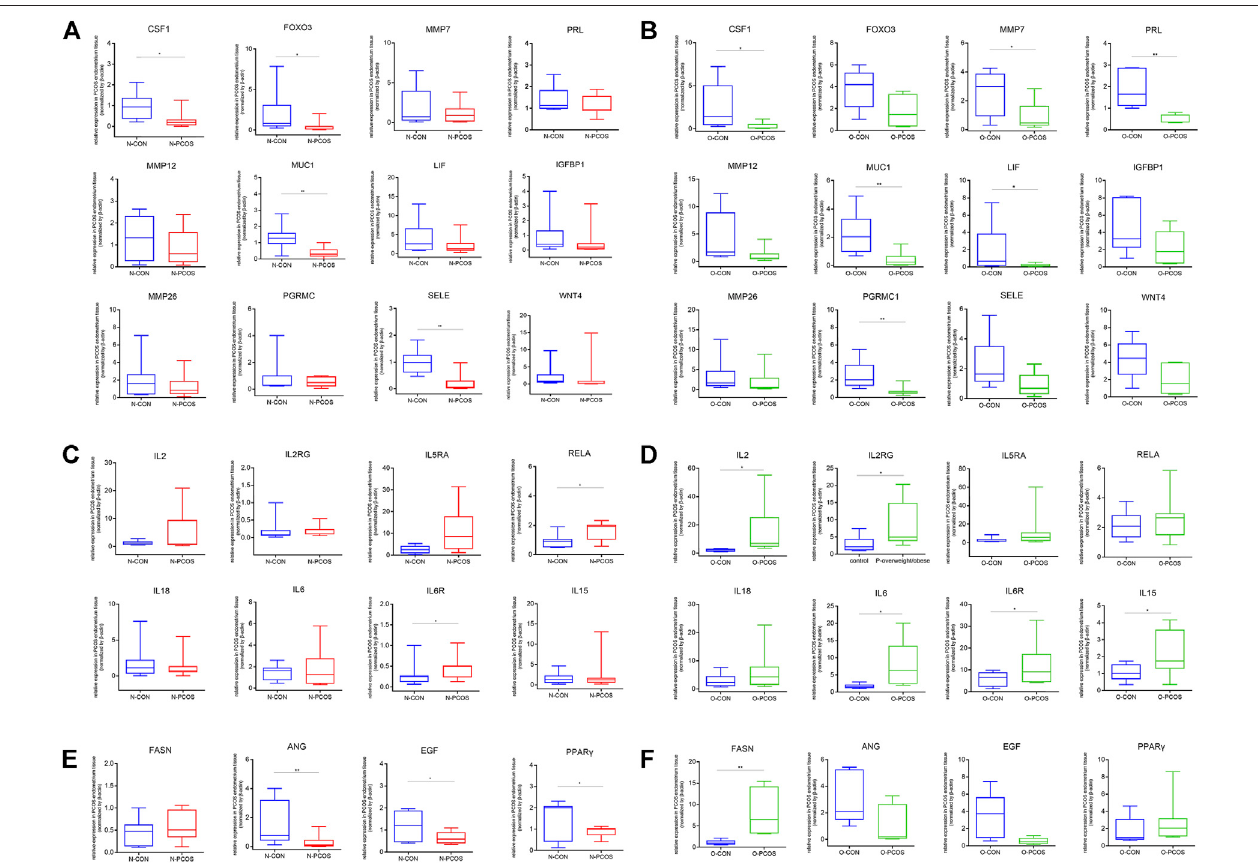
FIGURE 4 | Validation of selected genes by quantitative RT-PCR. Quantitative RT-PCR was performed to compare the gene expression levels of 38 subjects, including 13 N-PCOS, 9 O-PCOS, 10 N-CON, and 6 O-CON. Y -axis indicates the relative expression scale. The data are presented in a boxplot. (A) Endometrial receptivity and decidualization-related gene expressions between N-PCOS and N-CON. (B) Endometrial receptivity and decidualization-related gene expressions between O-PCOS and O-CON. (C) In fl ammatory gene expressions between N-PCOS and N-CON. (D) In fl ammatory gene expressions between O-PCOS and O-CON. (E) Endometrial angiogenesis and energy metabolism-related gene expressions between N-PCOS and N-CON. (F) Endometrial angiogenesis and energy metabolism-relatedgeneexpressionsbetweenO-PCOSandO-CON. β -Actinwasusedastheinternalcontrolgene,andtheexpressionlevelwasevaluatedbyusingthe ΔΔ Ct method. * p < 0.05, ** p < 0.01, and *** p <